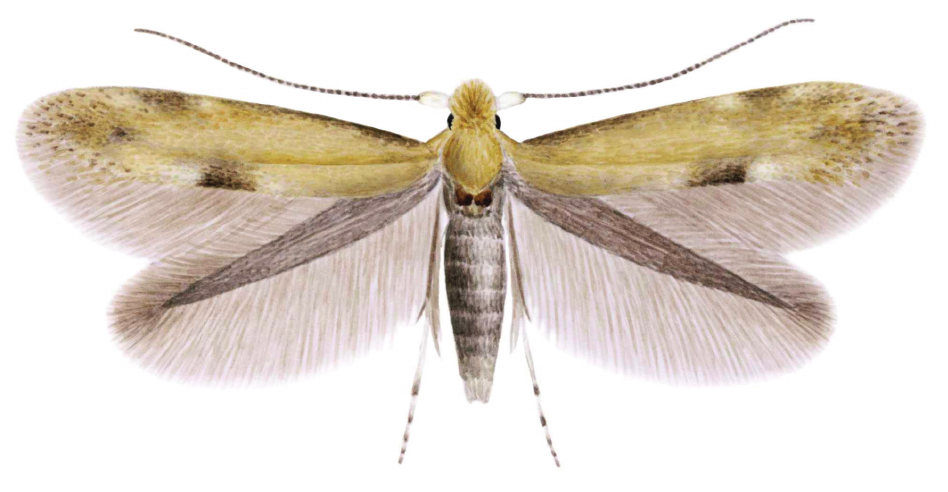
Figure 2. Bucculatrix brunnella sp. n., female, paratype, Mount Etna, Nicolosi, 20.vi.2008, wingspan 6.5 mm. costa narrowly edged dark brown to three­fifths, and with dark brown spot at the end edged from creamy white to light ochreous, some brown apical scales, a conspicuous dark brown dorsal spot edged creamy white to light ochreous at three­quarters and a dark brown subapical spot. Male genitalia (Fig. 3). Uncus and gnathos absent. Socii developed to form two slender setose lobes, moderately enlarging at the rounded apex. Vinculum relatively narrow, elongated. Valva slender, gradually tapering distad from base to a pointed apex. Several short stout setae at apex. Phallus long, slender tube swollen at base, 2.7 times longer than